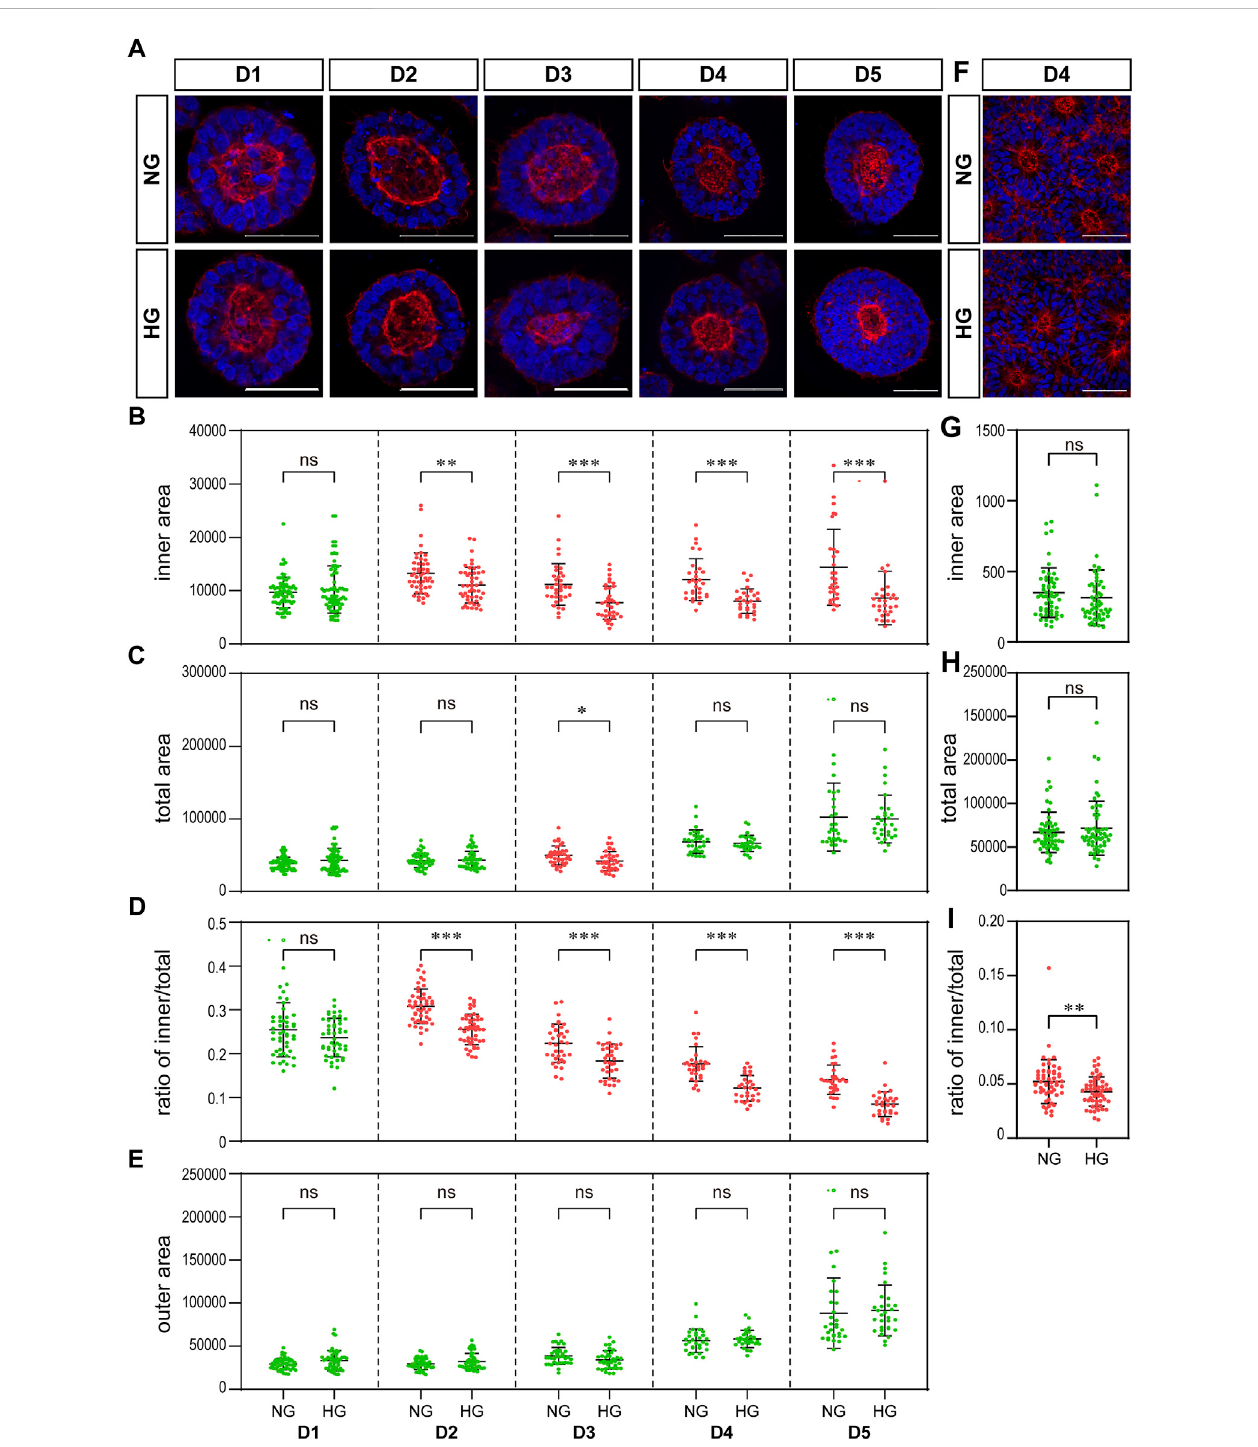
FIGURE 4 High glucose results in a signi fi cant reduction in the actin inner boundary enclosed area in the 3D model and the ratio of inner to total area in the rosette model. (A) Representing F-actin (red) immuno fl uorescence imagesinthenormal(NG)and 2x high glucose (HG) groups atD1-5 of neuroepithelial cysts. DAPI (blue)showsthenucleus.Scalebaris50 μ m( B – E) .Theinnerareaenclosedbytheactininnerboundary (B) andthetotalareaenclosedbyactinouterboundary (C) weremeasuredbyImageJsoftware.Theratiooftheinnertototalarea (D) andtheouterareaoccupiedbycells (E) werecalculated.N ≥ 30/condition. (F) .RepresentingF-actin(red)stainingimagesinthenormal(NG)and2xhighglucose(HG)groupsatD4afterpassageoftherosettemodel.DAPI(blue)shows the nucleus. All scale bar = 50 μ m. The inner area enclosed by the actin inner boundary (G) and the total area enclosed by actin outer boundary (H) were measured by ImageJ software, and the ratio of the inner to total area (I) were calculated. N ≥